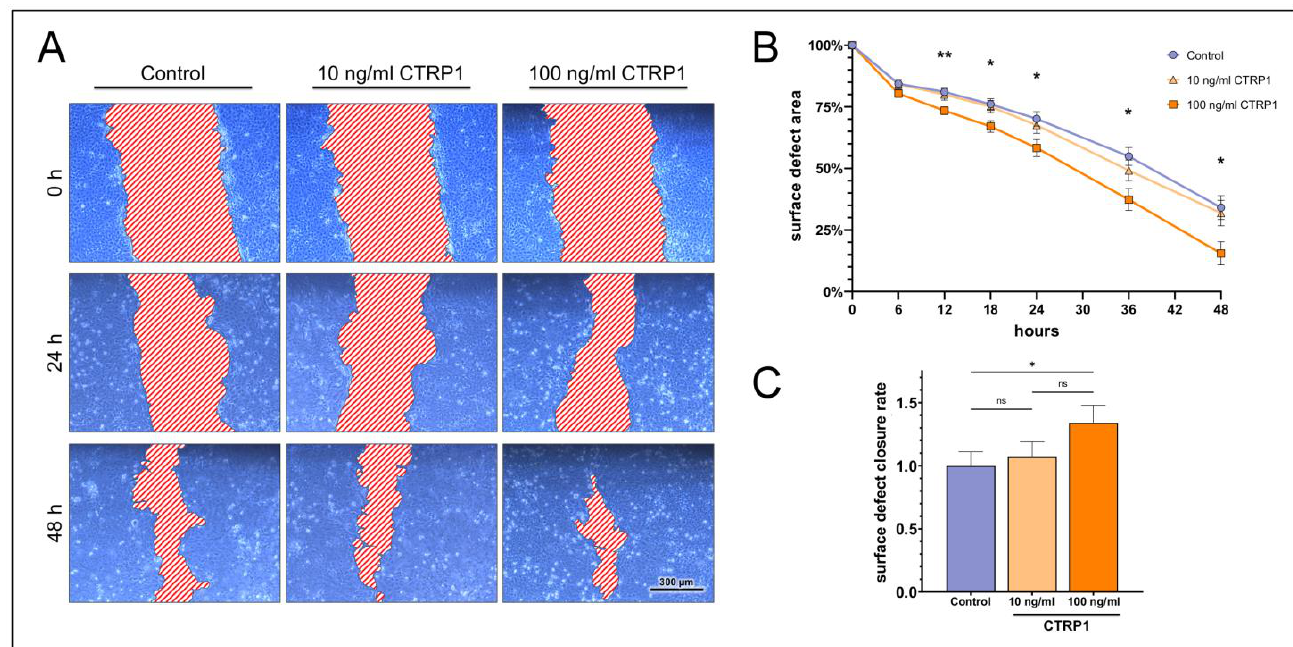
Figure 4. Scratch assays show the dose-dependent impact of CTRP1 on surface defect closure in human corneal epithelial cells (HCE). ( A ) After performing the initial scratch, HCE cells were stimulated with 0, 10, or 100 ng/mL recombinant human CTRP1 for 48 h. The surface defect was measured in a representative segment of a scratch ( n = 9) at different time points and compared to untreated cells (control). ( B ) Relative surface defect area ± SEM over time. The graph shows a significant decrease in the relative surface defect area in cells treated with 100 ng/mL CTRP1 compared to the control (two-way ANOVA; * p < 0.05; ** p < 0.01). Treatment with 10 ng/mL CTRP1 had no significant effect on the surface defect area when compared to the control (two-way ANOVA; p > 0.05). ( C ) Fold-increase in the surface defect closure rate. Bars represent mean ± SEM. 100 ng/mL CTRP1 increased the relative surface defect closure rate significantly compared to the control (one-way ANOVA; * p < 0.05), while 10 ng/mL CTRP1 was ineffective (one-way ANOVA; ns = not significant, p > 0.05). The difference in the surface defect closure rate between HCE cells treated with 10 ng/mL and 100 ng/mL CTRP1 was not significant (one-way ANOVA; ns = not significant, p > 0.05).